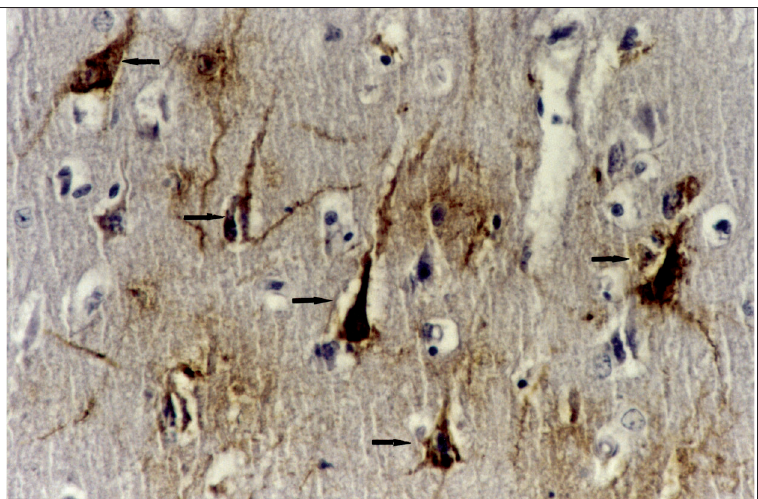
Figure 2. Immunoperoxidase staining of a brain section of a bovine herpesvirus type 5 (BHV-5)-infected calf. BHV-5 antigen in neurons of the cerebral cortex (arrows). Avidin- biotin peroxidase detection system using mAb 2F9. Substrate: diaminobenzidine. Hema- toxylin counterstaining. Magnification